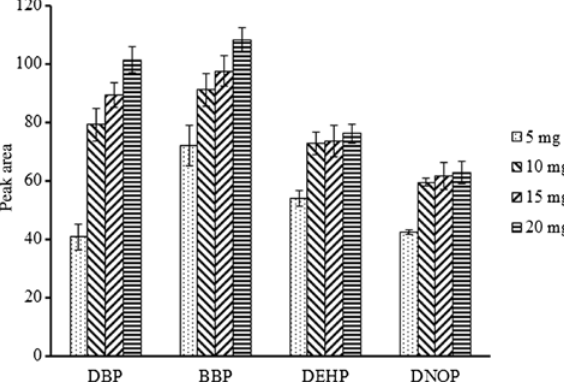
O @SiO -Ph on the 3 4 2